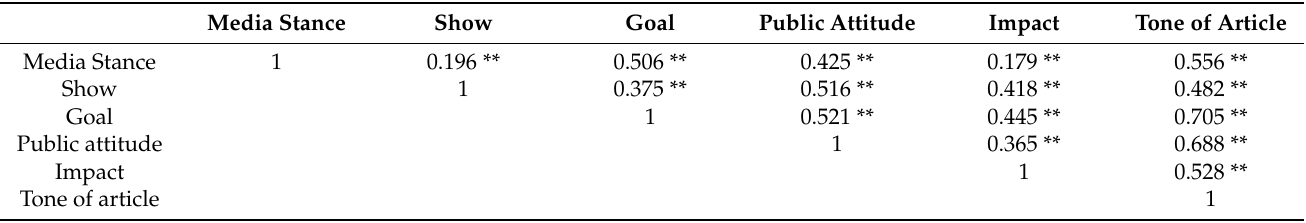
Table 5. The correlation between media stance and “Protest